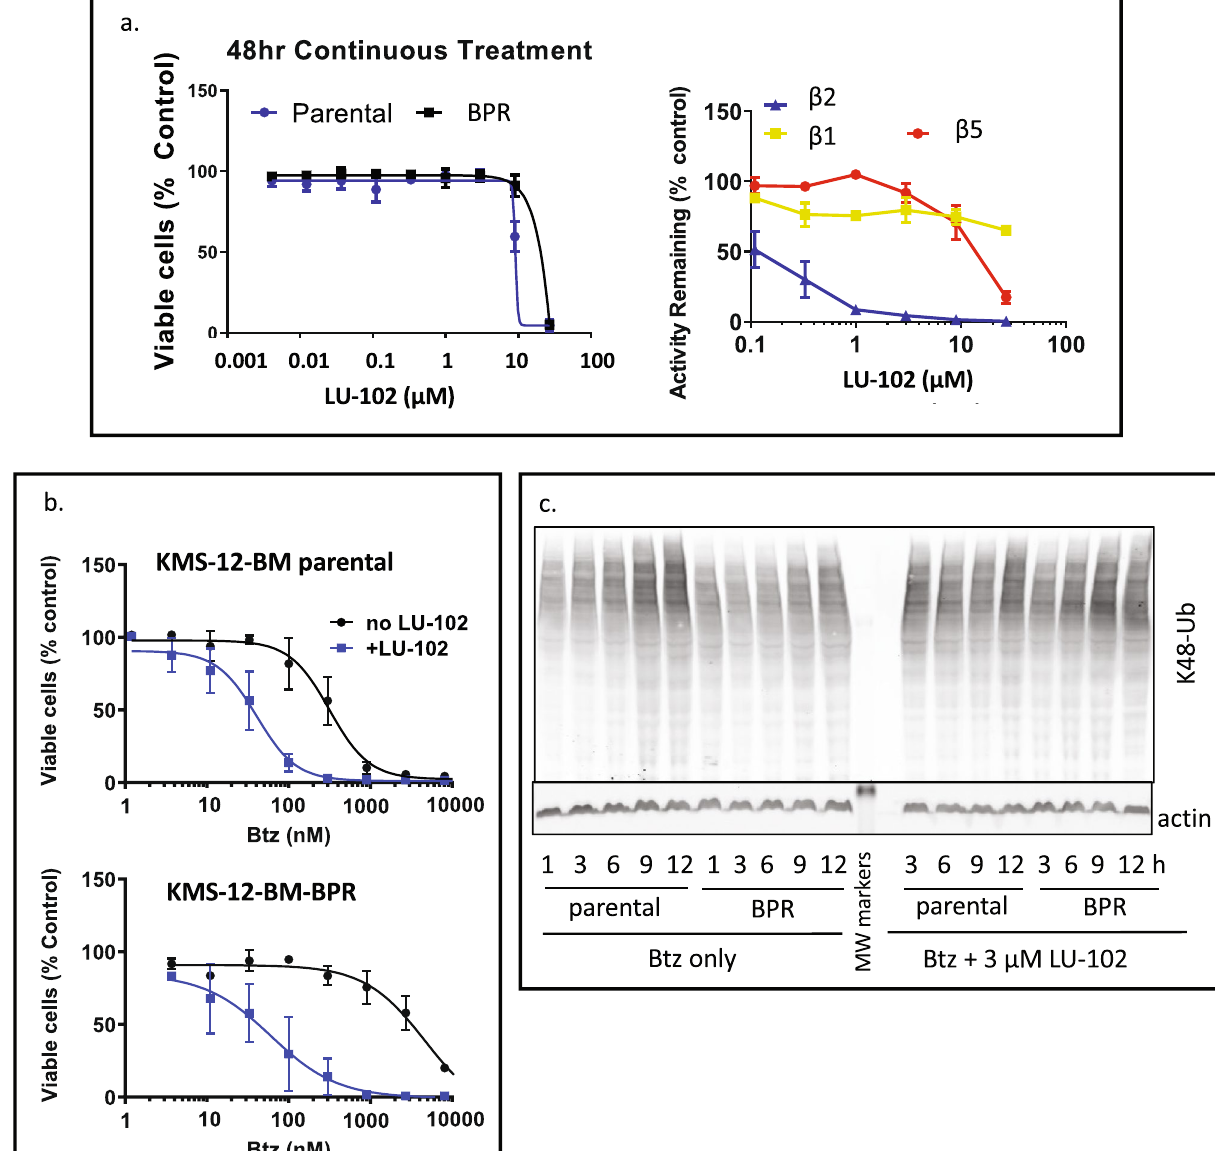
Figure 3. LU-102 overcomes resistance in BPR cells. ( a ) Effect of a single agent LU-102 treatments. Cells were treated continuously with LU-102 for 48 h before viability was determined using Alamar Blue; in a parallel experiment, activity was measured with Proteasome Glo 2 h after treatment; n = 2. ( b ) Cells were treated with Btz for 1 h when it was replaced with 3 µM LU-102 for 48 h, when Alamar Blue assay was performed, n = 2–3. ( c ) Cells were treated with 1 µM Btz for 1 h and then allowed to recover in media in the presence or absence of 3 µM LU-102. Cell lysates were analyzed by westerns. Uncropped images are presented in Fig.